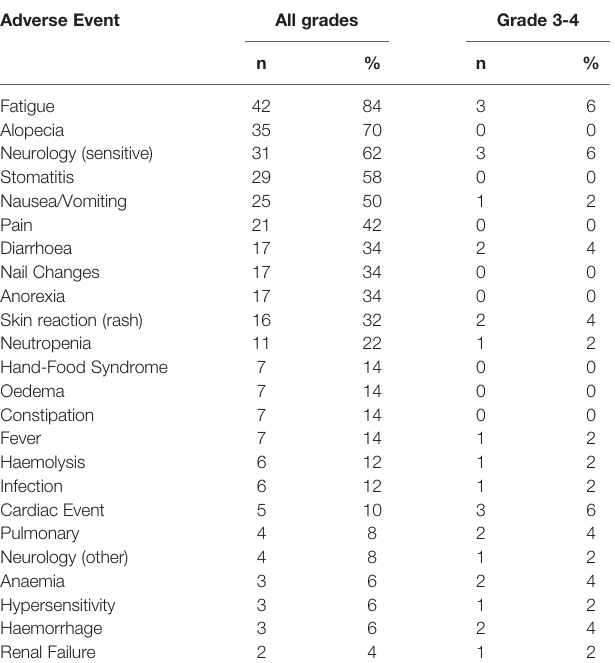
TABLE 2 | Most frequent